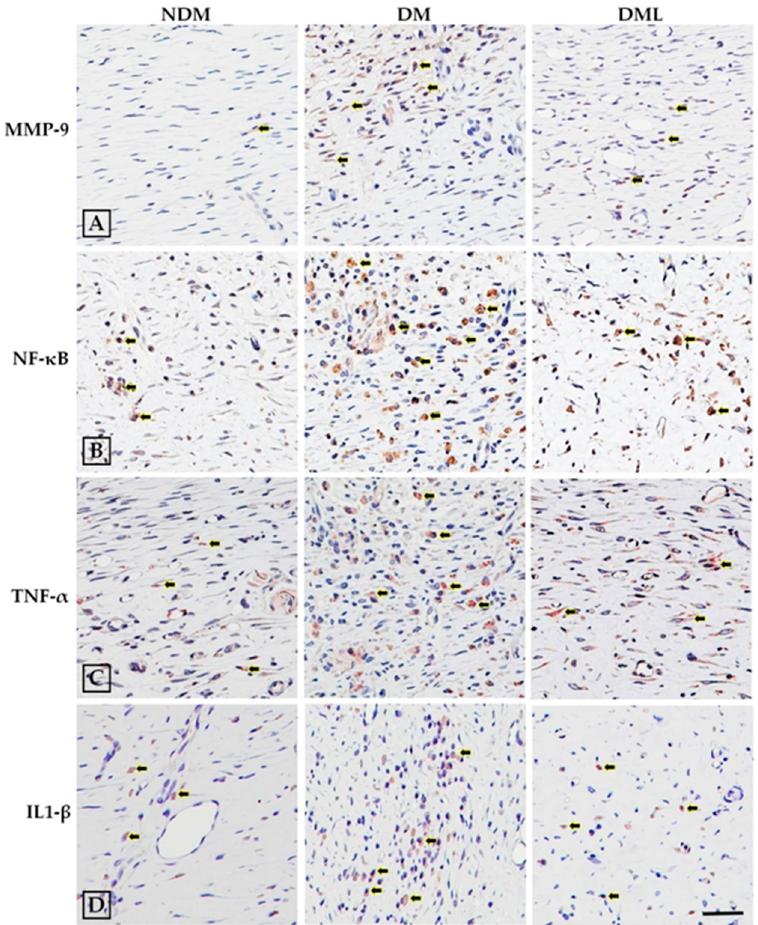
Figure 5. Luteolin ameliorated inflammatory factors. To determine the inflammatory factors, tissue sections obtained from skin wound on day 14 were analyzed using immunohistochemistry for ( A ) MMP-9, ( B ) NF- κ B, ( C ) TNF- α , and ( D ) IL1- β . Brown areas indicate positive staining (arrowheads). Scale bars: 100 μ m.